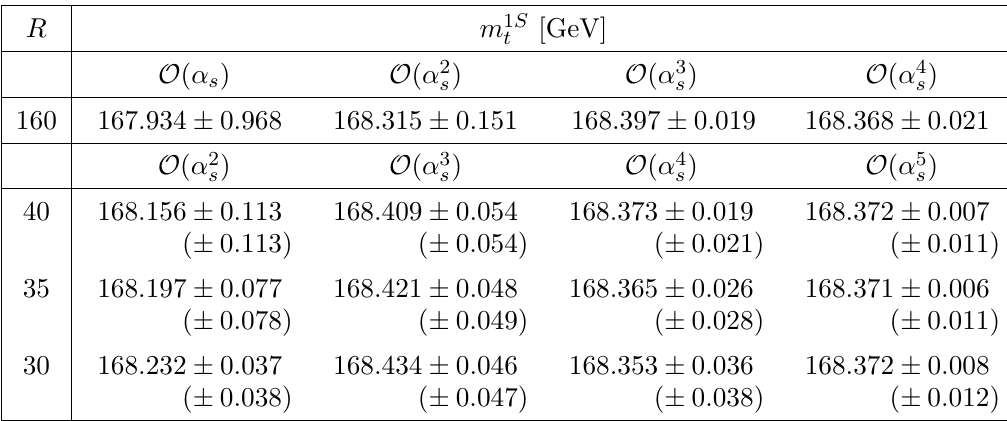
Table 5. Results for the top mass in the 1S mass scheme at di(cid:11)erent orders using as input the practical MSR mass m MSRp ( m MSRp t